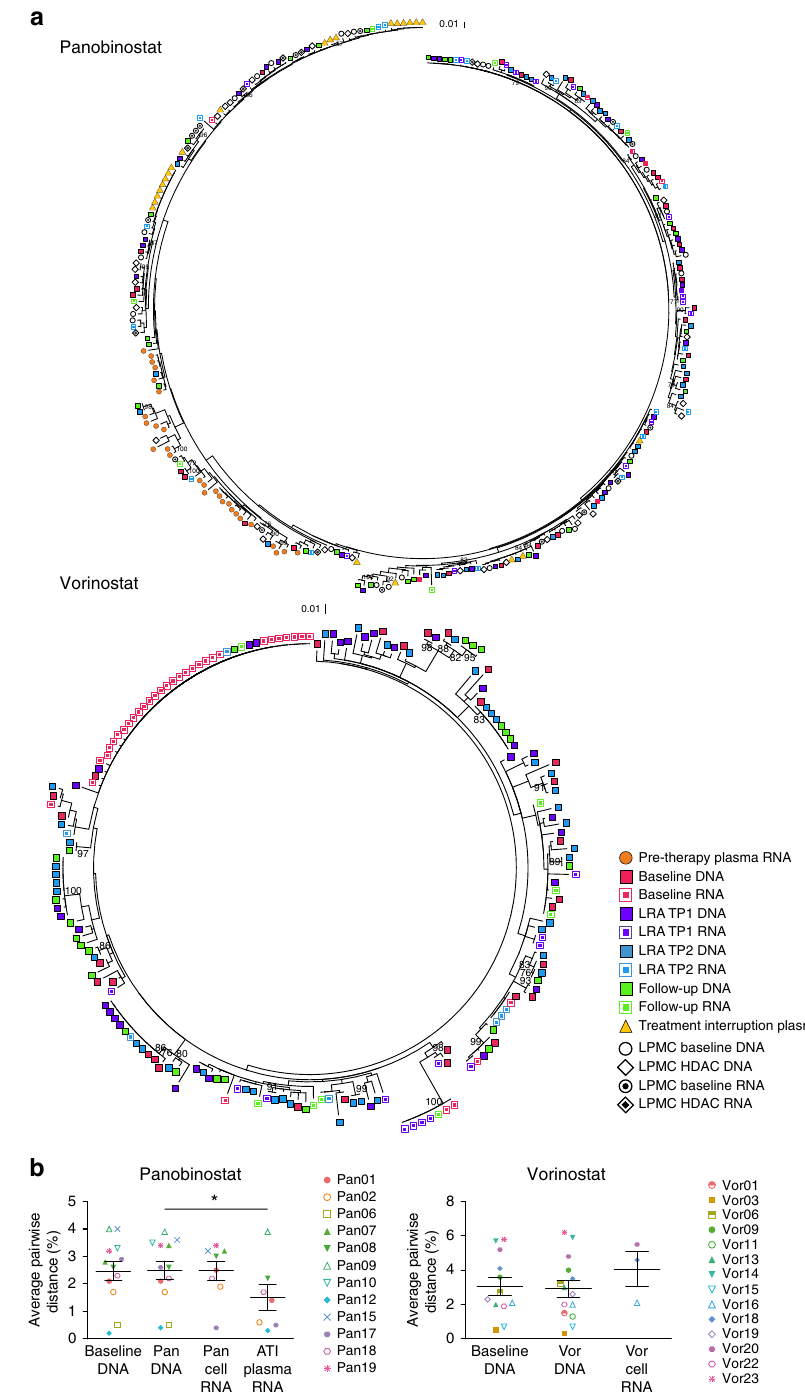
Figure 1 | Panobinostat and vorinostat non-selectively activate transcription from latent HIV-1 proviruses. ( a ) Representative phylogenetic trees of HIV-1 sequences from HIV-infected participants on suppressive ART who received panobinostat (Pan18) or vorinostat (Vor16) showing the genetic relationship of sequences from each time point. For participant Pan18, the plasma samples were collected B 1 year and 6 months before initiation of antiretroviral therapy and 14 days following the analytical treatment interruption. Peripheral blood samples were collected at baseline, 2h after the first dose of panobinostat (TP1), 32 days after the first dose of panobinostat (TP2) and 38 days after the final panobinostat dose. Intestinal lamina propria mononuclear cells were collected at baseline (1 week before the first panobinostat dose) and during week 4 of the panobinostat trial. For participant Vor16, peripheral blood samples were collected at baseline, 7 days after the first dose of vorinostat (TP1), 14 days after the first dose of vorinostat (TP2) and 7 days after the final vorinostat dose. ( b ) Average pairwise distance of cell-associated DNA (Pan n ¼ 12, Vor n ¼ 12) before and DNA (Pan n ¼ 12, Vor n ¼ 14) and cell-associated RNA (Pan n ¼ 8, Vor n ¼ 3) during vorinostat and panobinostat administration, as well as the plasma HIV-1 RNA following an ATI for the panobinostat trial ( n ¼ 7). Each data point represents the group mean ± s.e.m. The Wilcoxon signed rank test was used to generate the P values. * P r